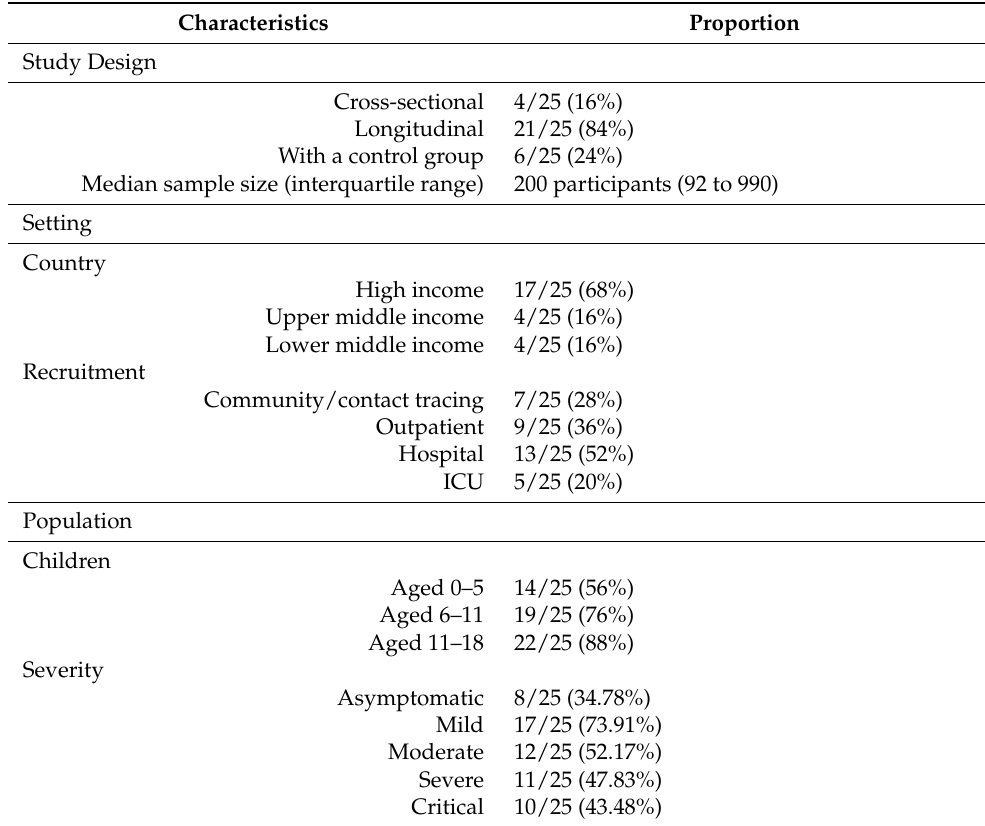
Table 1. Characteristics of included